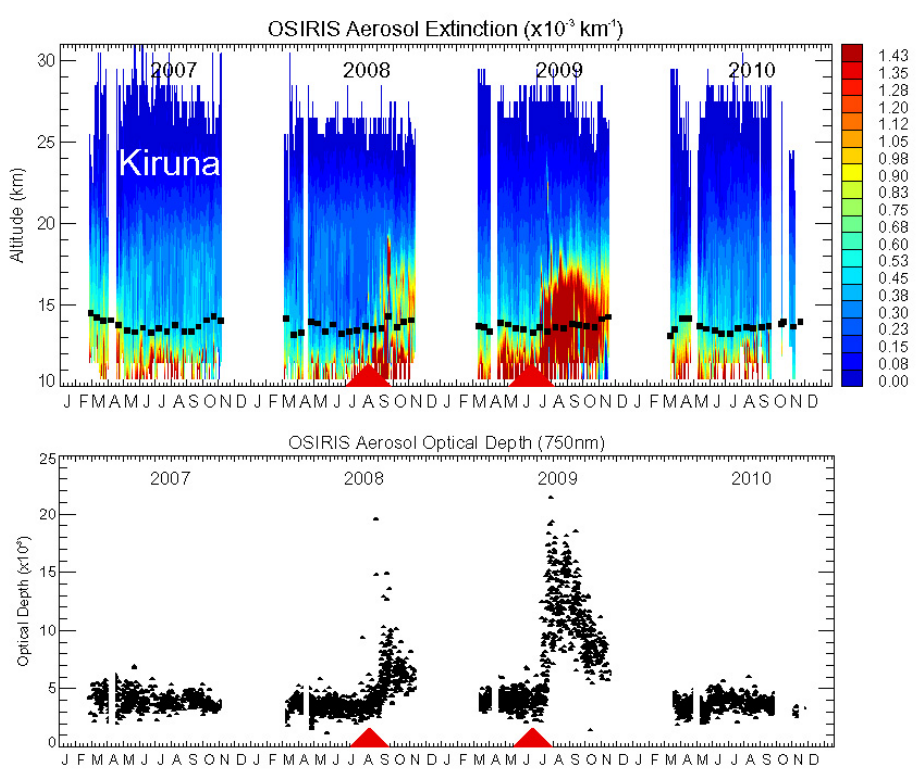
Fig. 4. Evolution of the extinction coefficient (top) and AOD (bottom) between 10 and 30km measured by the OSIRIS instrument on board the ODIN satellite over Kiruna region ( ± 10 ◦ lat–long box) during the 2007–2010 period. The 380K potential temperature level is indicated 20 by the black squares. The Kasatochi (2008) and the Sarychev (2009) eruptions are symbolized by the red triangles.